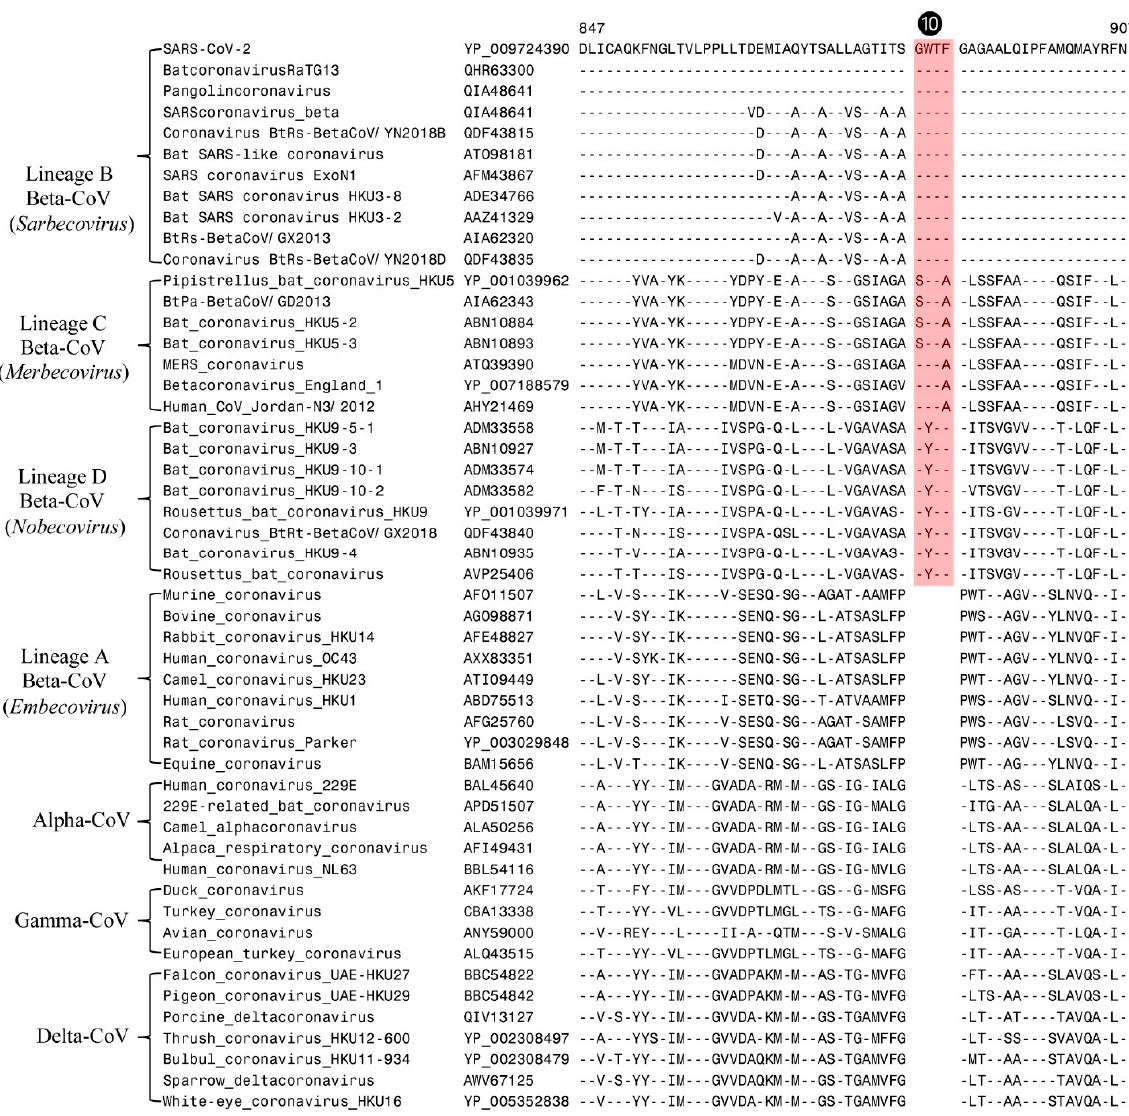
Figure 5. Excerpts from the sequence alignment of the spike protein showing a 4-aa CSI that is pre- sent only in the Betacoronavirus subgenera Merbecovirus, Nobecovirus , and Sarbecovirus . This CSI ( ❿ ) provides evidence that the CoVs from these subgenera are more closely related to each other, and they evolved after the divergence of other CoVs. No change is observed in this region in the Omi- cron